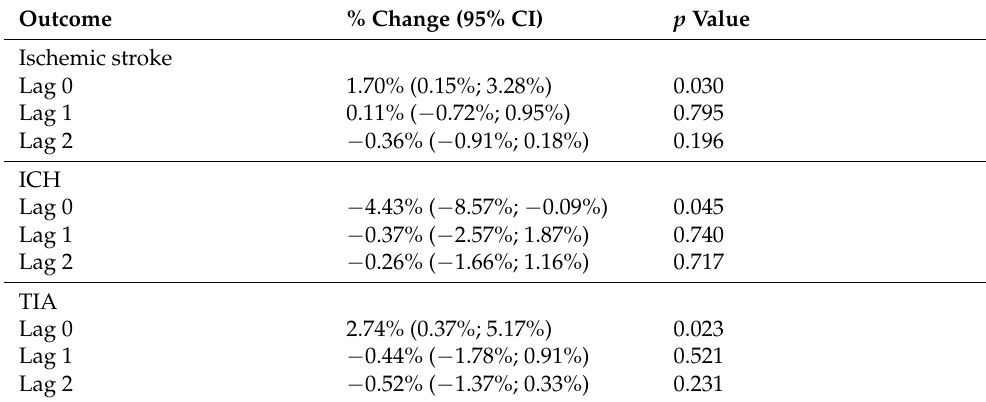
Table 2. The association between an IQR increase in PM 2.5 exposure and subtypes of